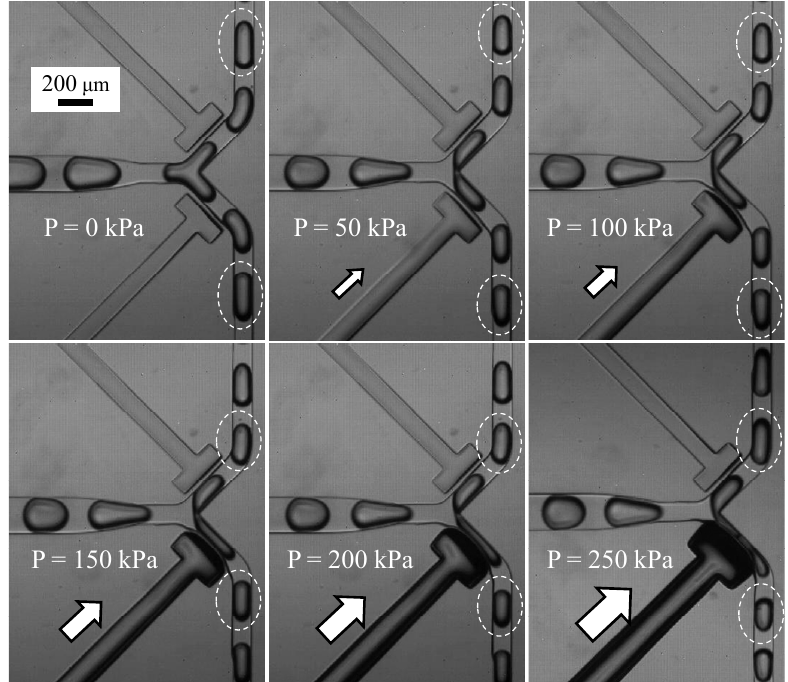
Figure 5. Visualization of droplet division with operation of pneumatic valves (Q = Q = 2 μ water oil